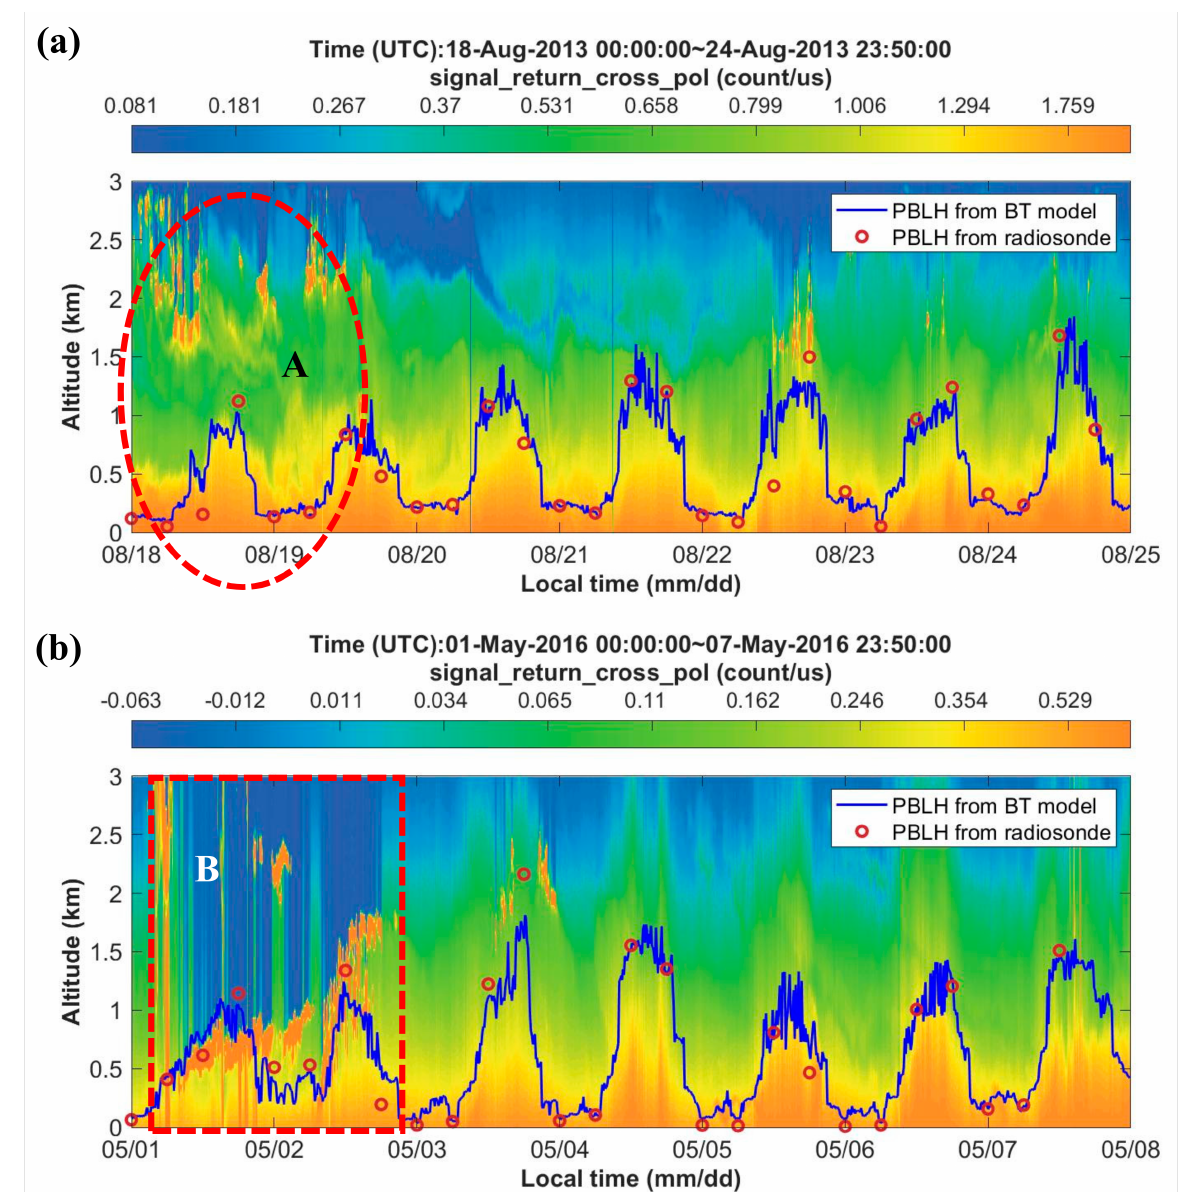
Figure 5. MPL signal measured from ( a ) 18 August 2013 to 24 August 2013 and ( b ) 1 May 2016 to 7 May 2016; PBLHs were determined with the BT model (blue line) and radiosonde (red